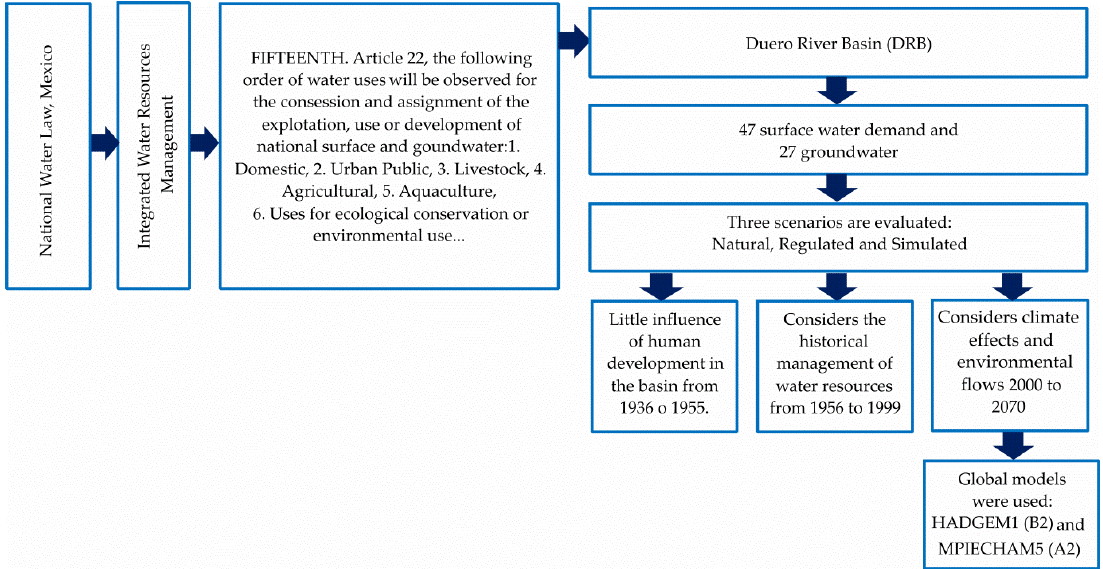
Figure 6. Water-planning model for the DRB, in which the priority and allocation of water were in accordance with Article 22, the Fifteenth National Water Law.